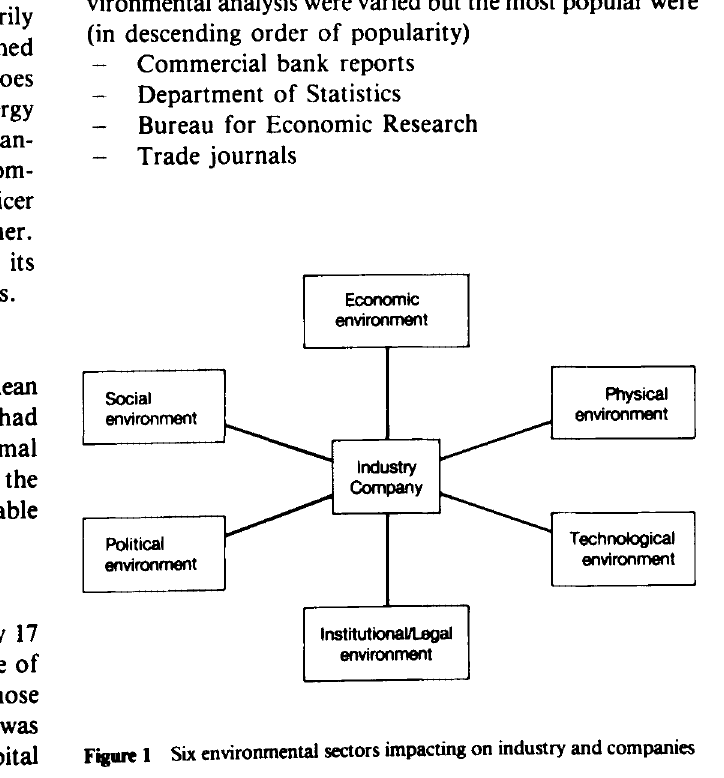
Figure 1 Six environmental sectors impacting on industry and